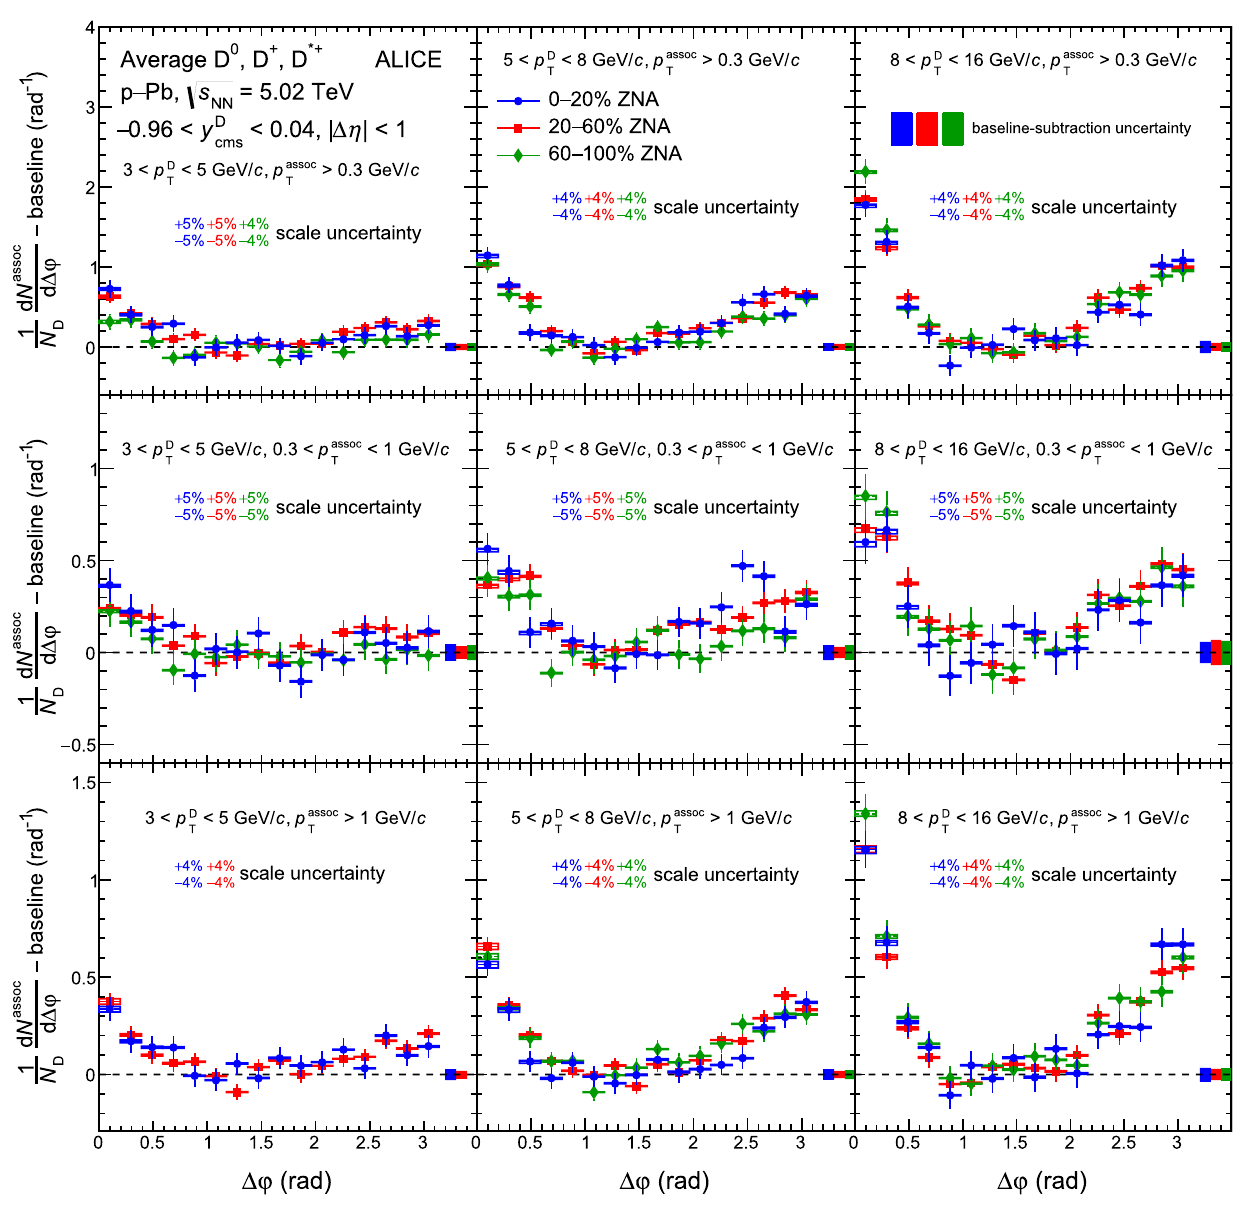
< 1 GeV / c , and p assoc > 1 GeV / c (from top to bot- Fig. 6 Average of the azimuthal-correlation functions of D 0 , D + , and 0 . 3 < p assoc T T D ∗+ mesons with associated particles, after the subtraction of the base- tom). Statistical and (cid:4)ϕ -dependent systematic uncertainties are shown as vertical error bars and boxes, respectively, while (cid:4)ϕ -independent line, for p–Pb collisions in three different centrality classes, 0–20% uncertainties are written as text. The uncertainties from the subtraction (blue circles), 20–60% (red squares), and 60–100% (green diamonds). < 5GeV / c ,5 < p D < 8GeV / c , of the baseline are displayed as boxes at (cid:4)ϕ > Thefunctionsareshownfor3 < p D T T < 16 GeV / c (from left to right) and p assoc > 0 . 3 GeV / c , and 8 < p D T T